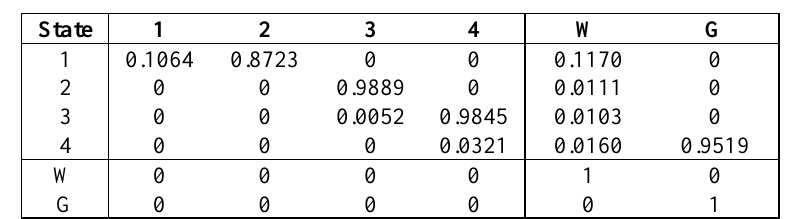
Table 8. The initial transition probability matrix